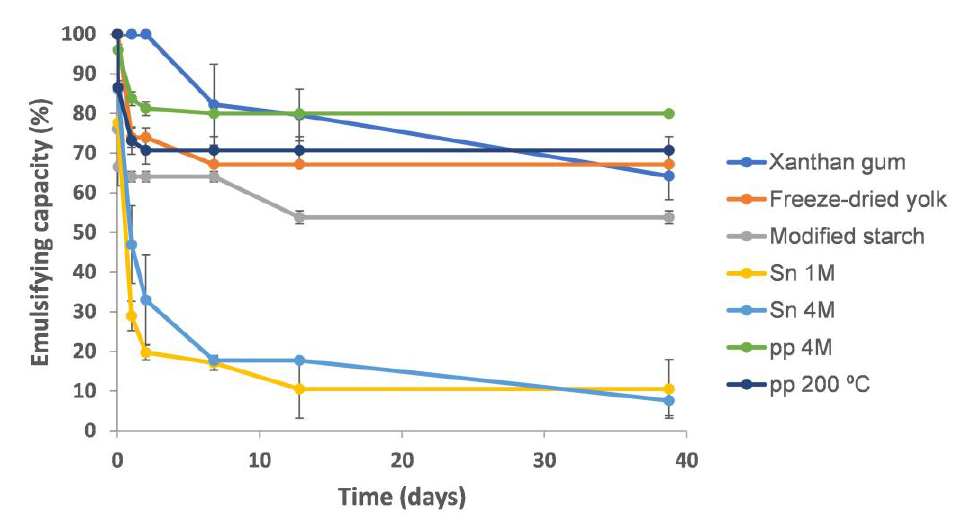
Figure 3. Emulsifying capacity of xanthan gum, freeze-dried yolk, modified starch, Sn 1M, Sn 4M, pp 4M and pp 200 °C, at a concentration of 2.5 mg/mL, in a mayonnaise emulsion model prepared with ultraturrax.